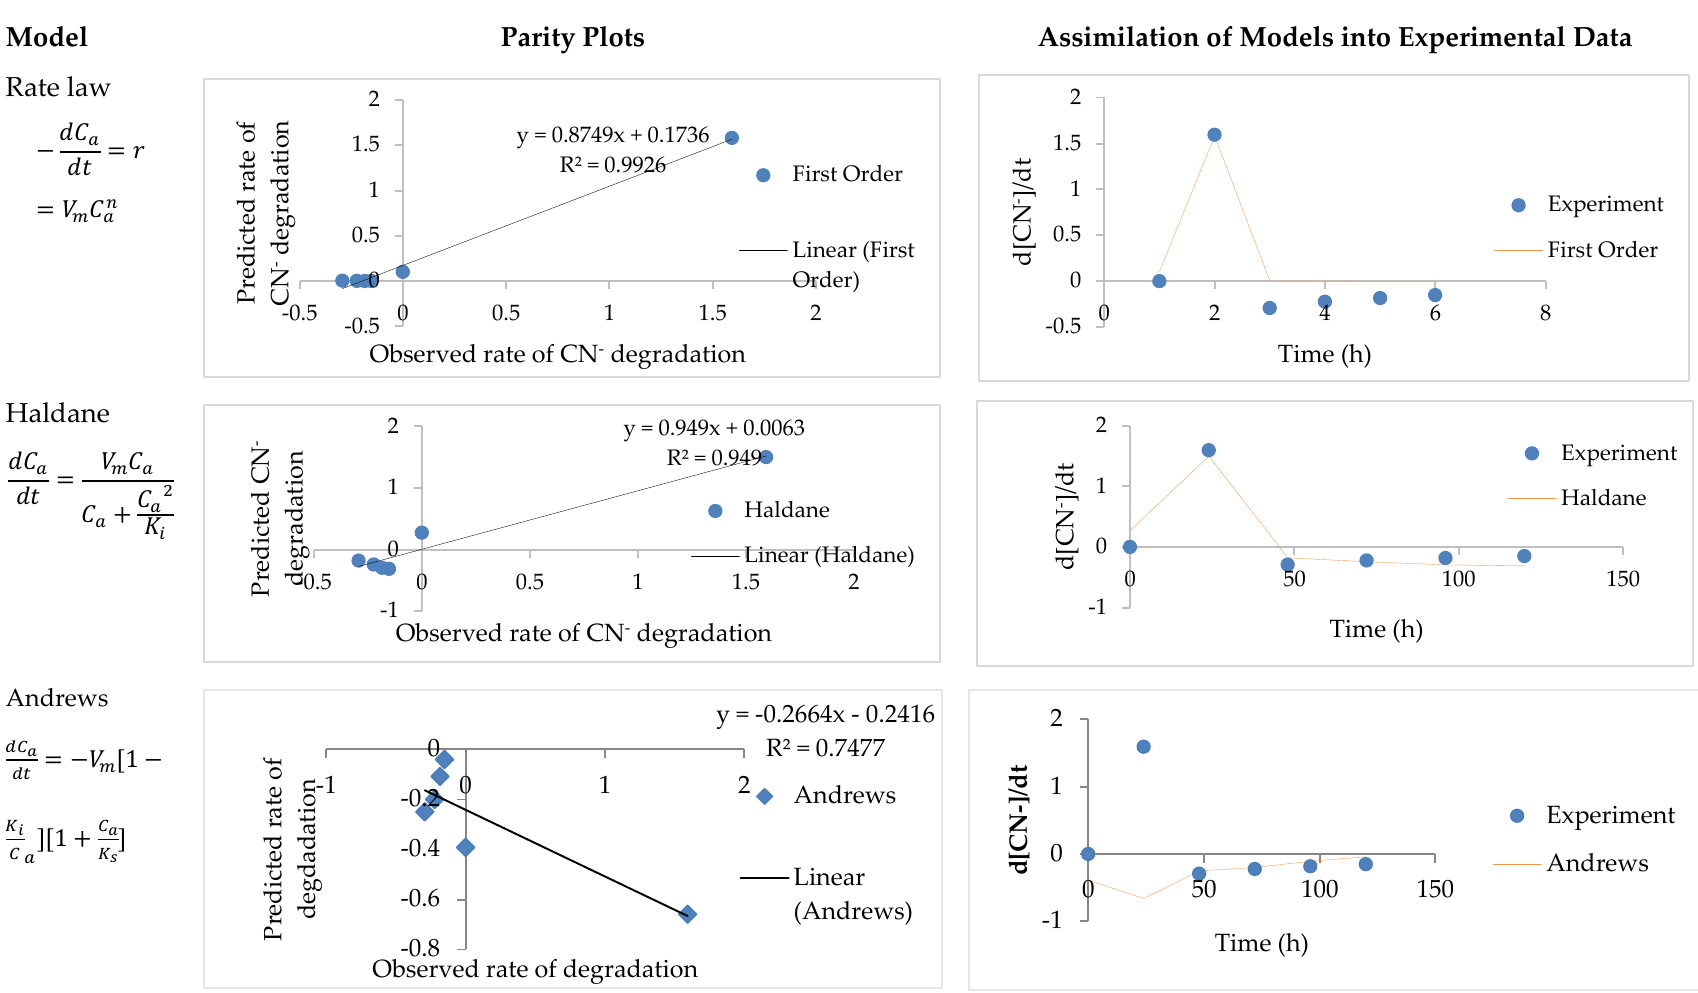
Figure 3. Parity plots of predicted values versus experimental values. Assimilations of the model data into CN − degradation experimental data (Rate law, Haldane, and Andrews).